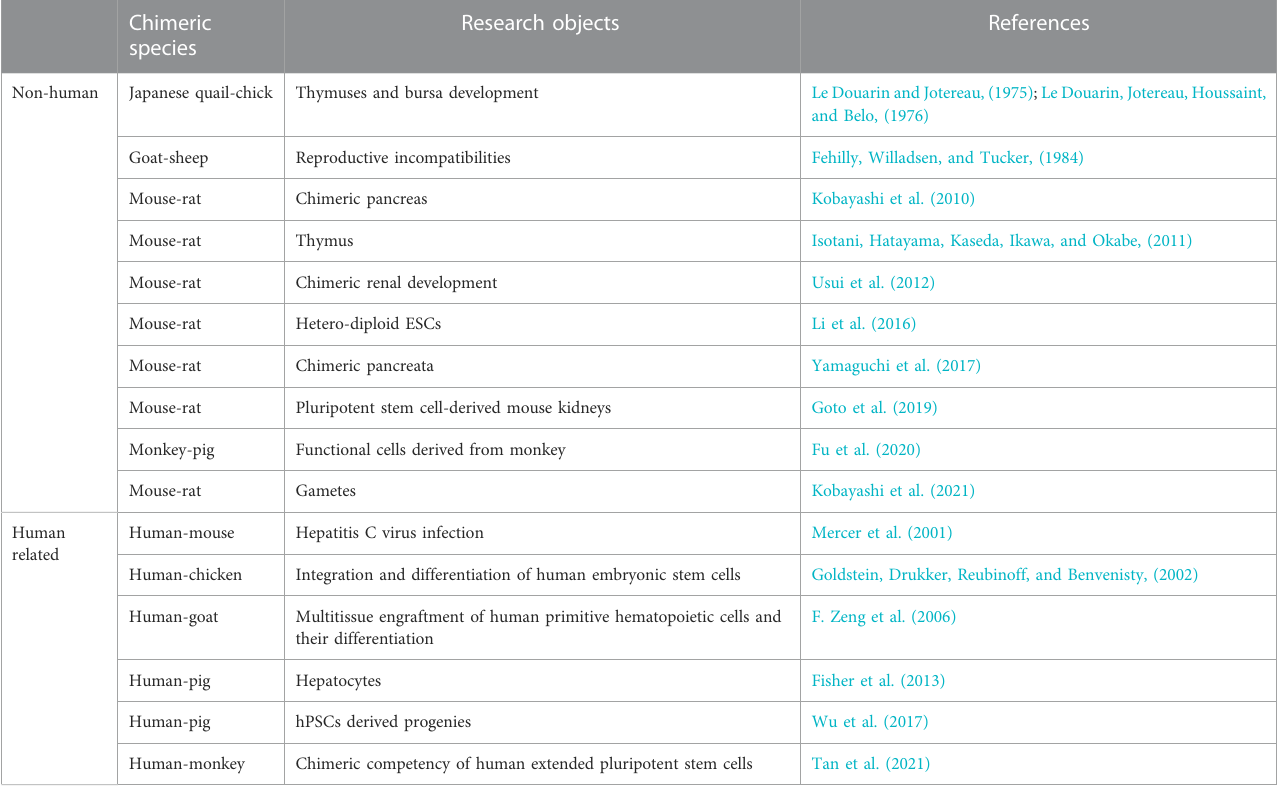
TABLE 2 Interspecies chimerism in different